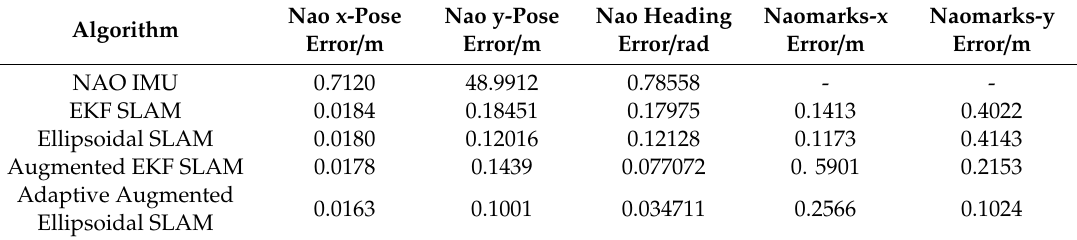
Table 2. Comparisons of the performances of implemented SLAM algorithms.